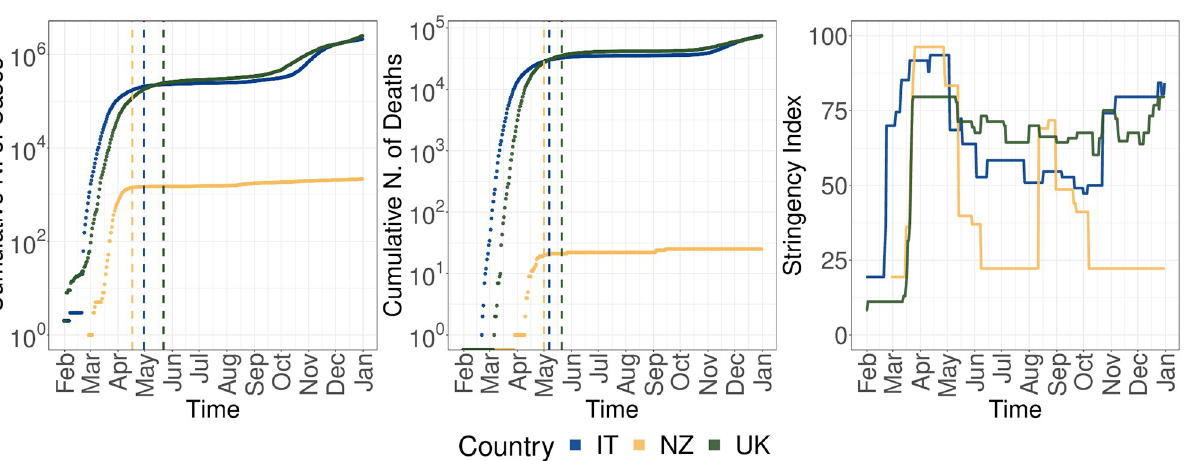
PLOS ONE | https://doi.org/10.1371/journal.pone.0267022 May 19,